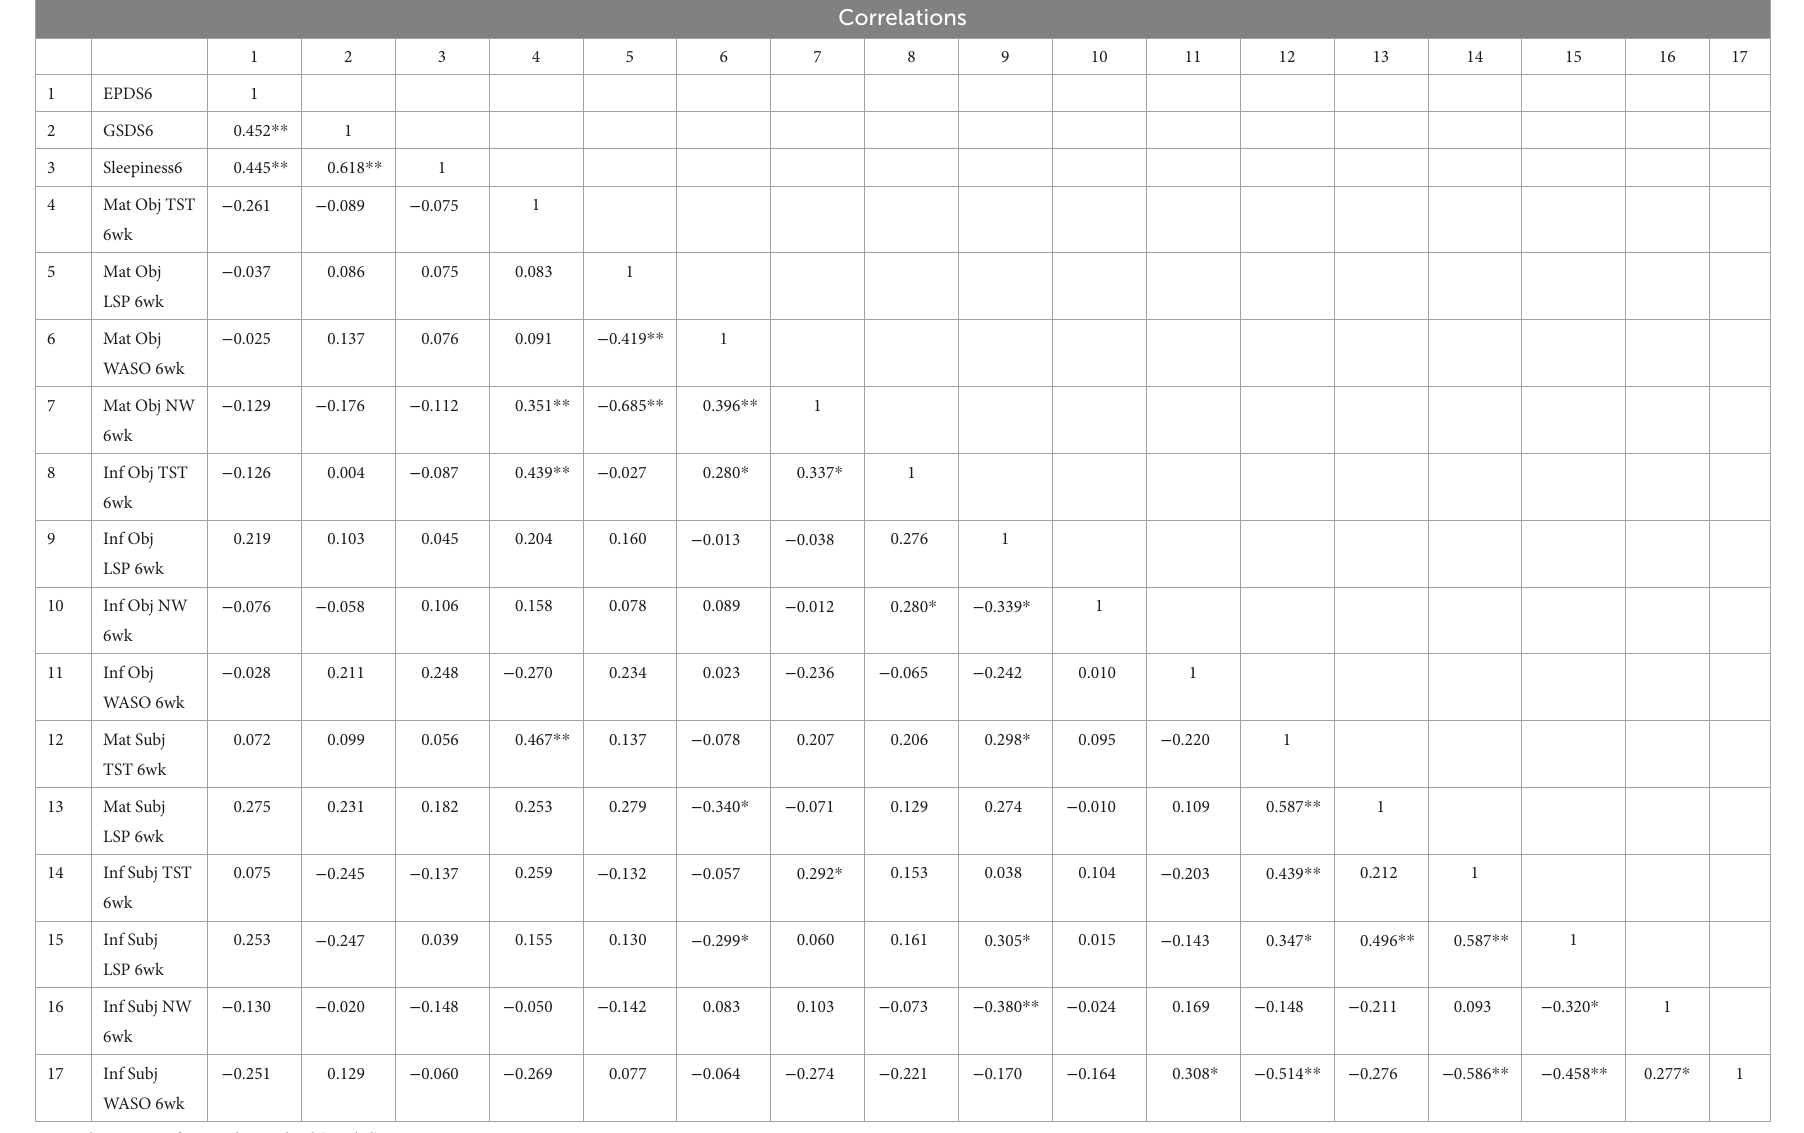
TABLE 3 Bivariate correlations between sleep measures, self-report measures, and EPDS at 6 weeks.